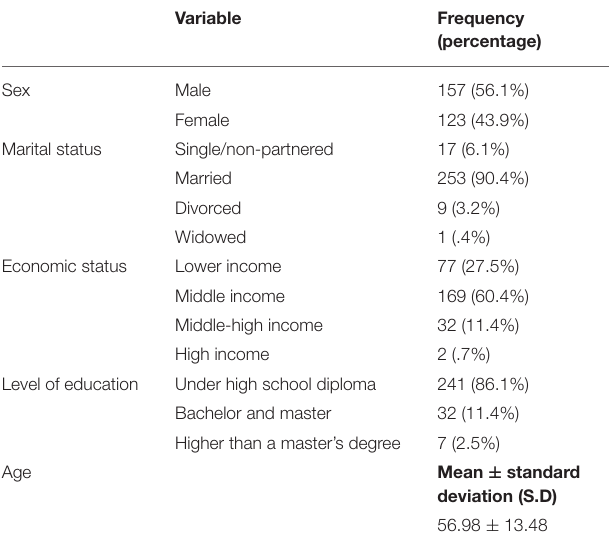
TABLE 1 | Demographic characteristics of the patients in the study ( n =